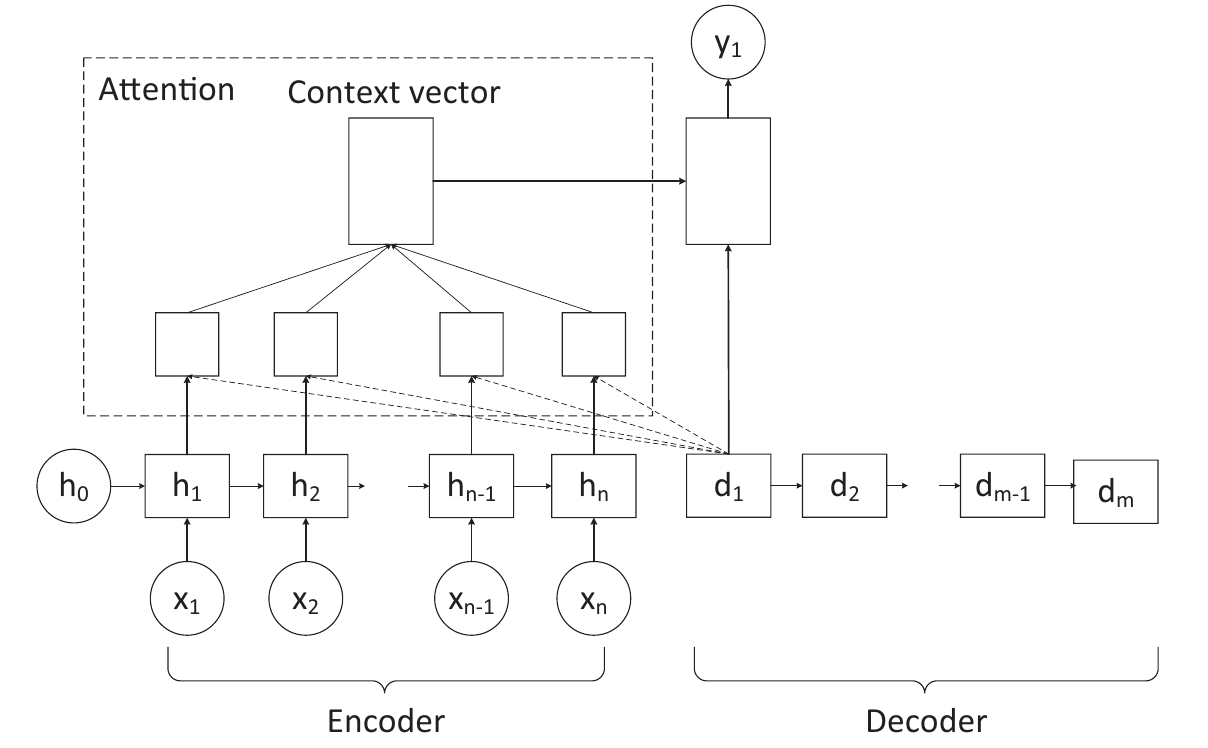
Figure 2. Seq2seq model with